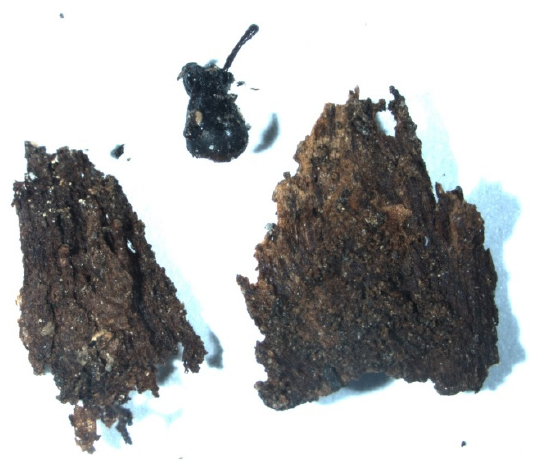
Figure 13. Remnants of cone scales and a chitinous head capsule of a weevil beetle in the Oa layer.